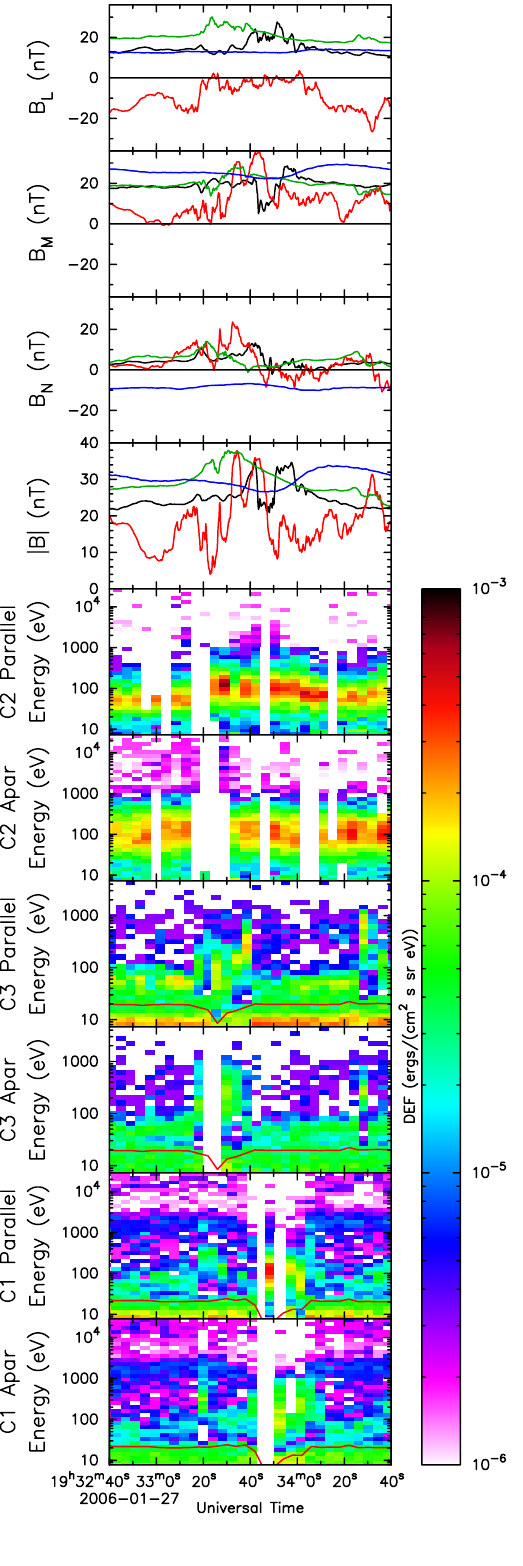
Fig. 7. An enlargement of the FTE signatures observed by the four Cluster spacecraft at 19:33UT, taking the same format as Fig.